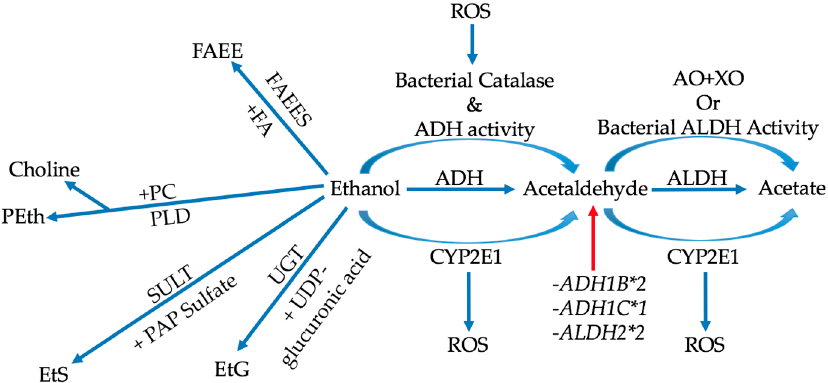
Figure 1. The majority of ethanol metabolism is oxidative where carcinogenic acetaldehyde is produced via alcohol dehydrogenase (ADH), CYP2E1, or bacterial catalases. The acetaldehyde is reduced by being converted to acetic acid by aldehyde dehydrogenase (ALDH), CYP2E1, or the combination of aldehyde oxidase (AO) and xanthine oxidase (XO). Conversion with CYP2E1 tends to produce reactive oxygen species (ROS), adding to carcinogenesis. Polymorphisms in the ADH and ALDH enzymes increase acetaldehyde concentrations (red arrow). Non-oxidative metabolism leads to the production of metabolites using various types of molecules. In the case of nucleotides, EtG and EtS are produced. For lipids, PEth and FAEE are produced. EtS = ethyl sulfate; SULT = sulfotransferase; PAP Sulfate = 3 ′ -phosphoadenosine-5 ′ -phospho sulfate; PEth = phosphatidylethanol; PC = phosphatidylcholine; PLD = phospholipase D.